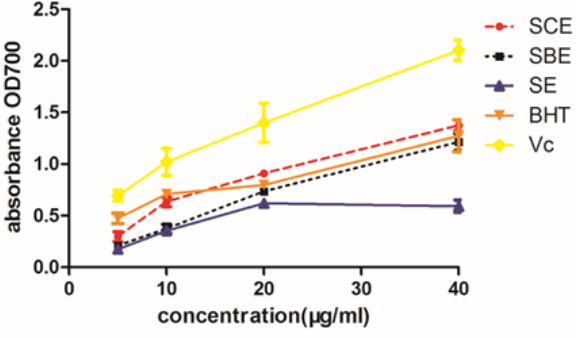
Figure 4: Reducing power of CEOs, Vc and BHT at the concentrations of 5, 10, 20, 40 μg/mL. Each value is expressed as mean ±